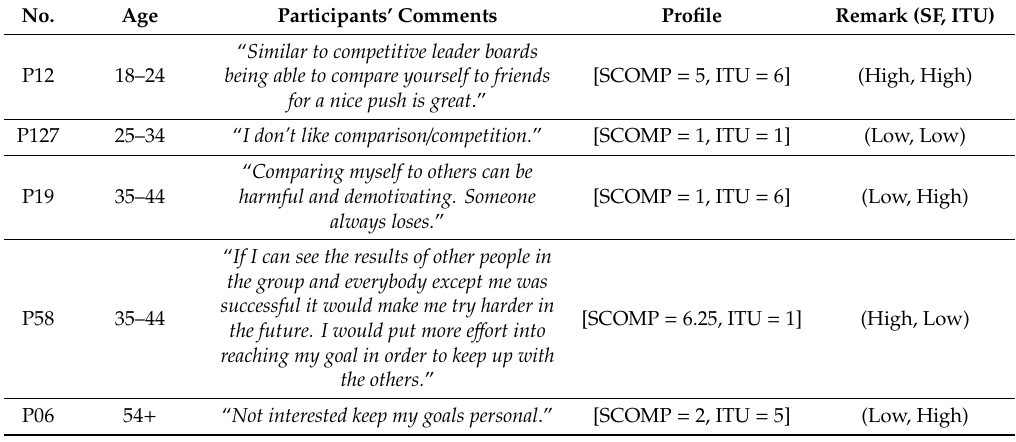
Table 6. Participants’ comments on social comparison feature and receptiveness profile.